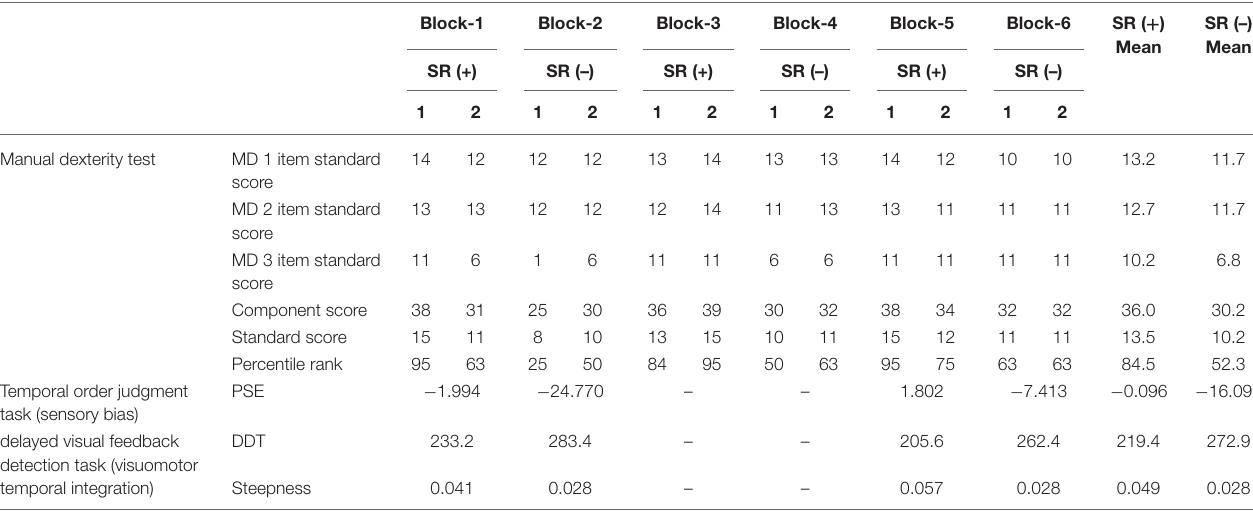
TABLE 2 | Measurement results of each index of each